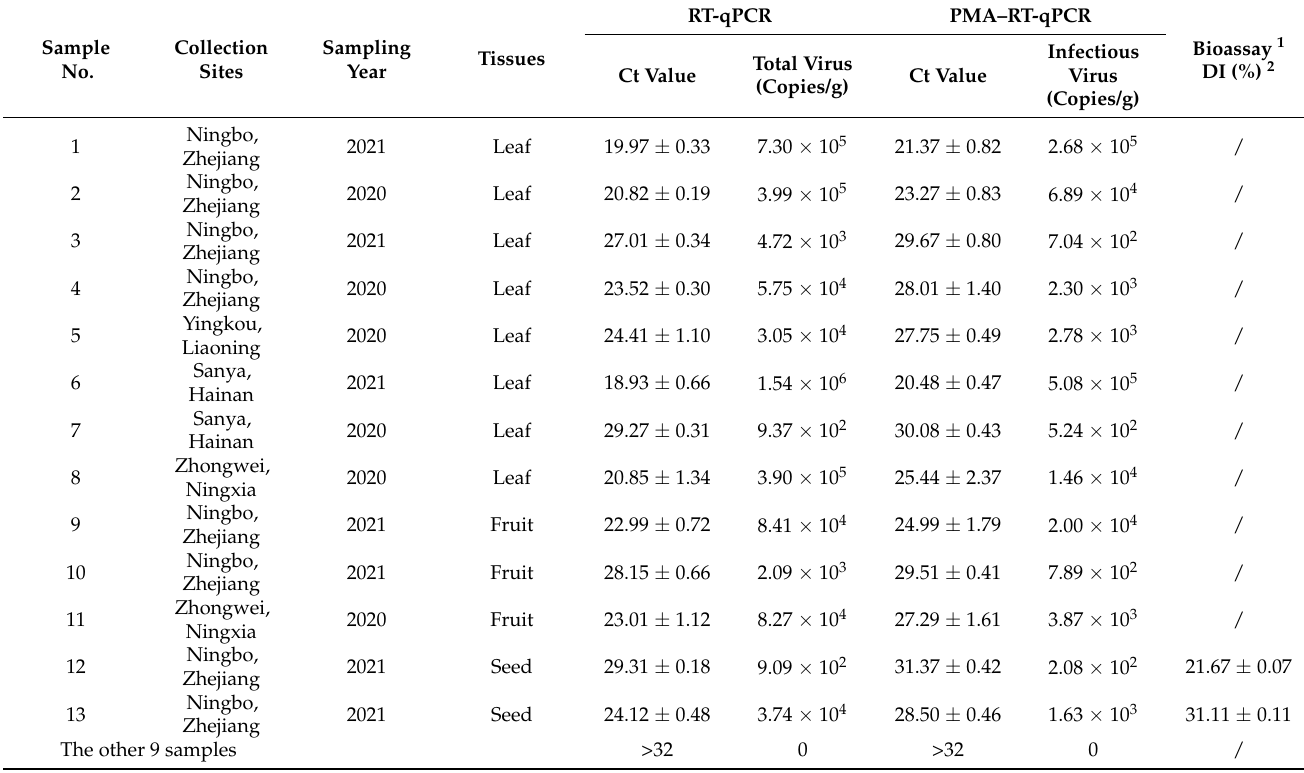
Table 3. Detection of total and infectious CGMMV in naturally infected tissues by RT-qPCR, PMA- RT-qPCR and seed bioassay 1